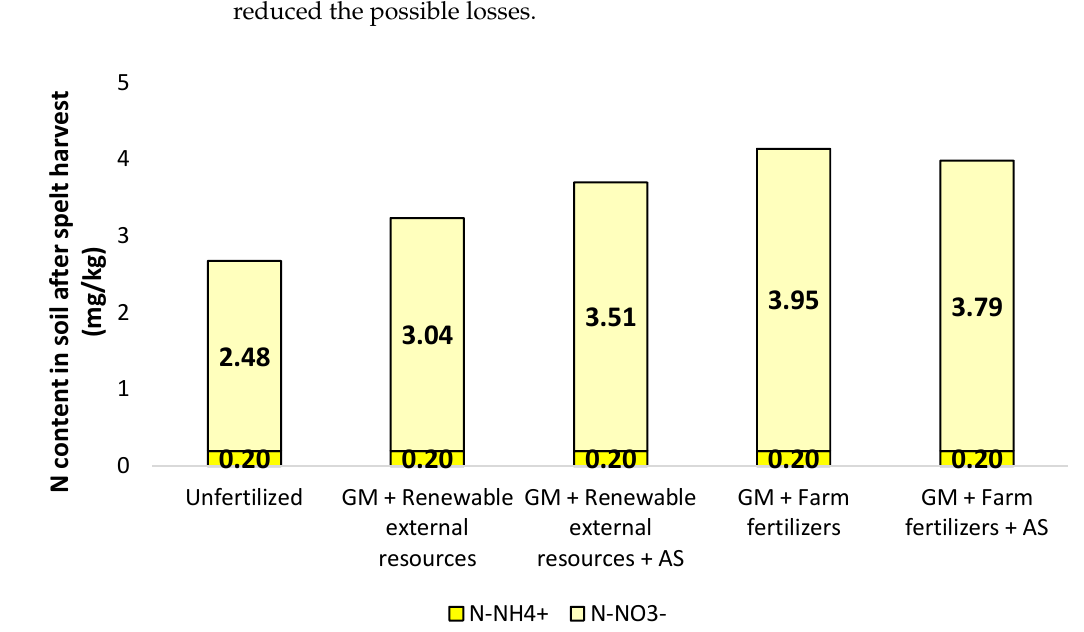
Figure 6. Content of mineral nitrogen in the soil after the harvest of spelt (observed treatments , 2017).